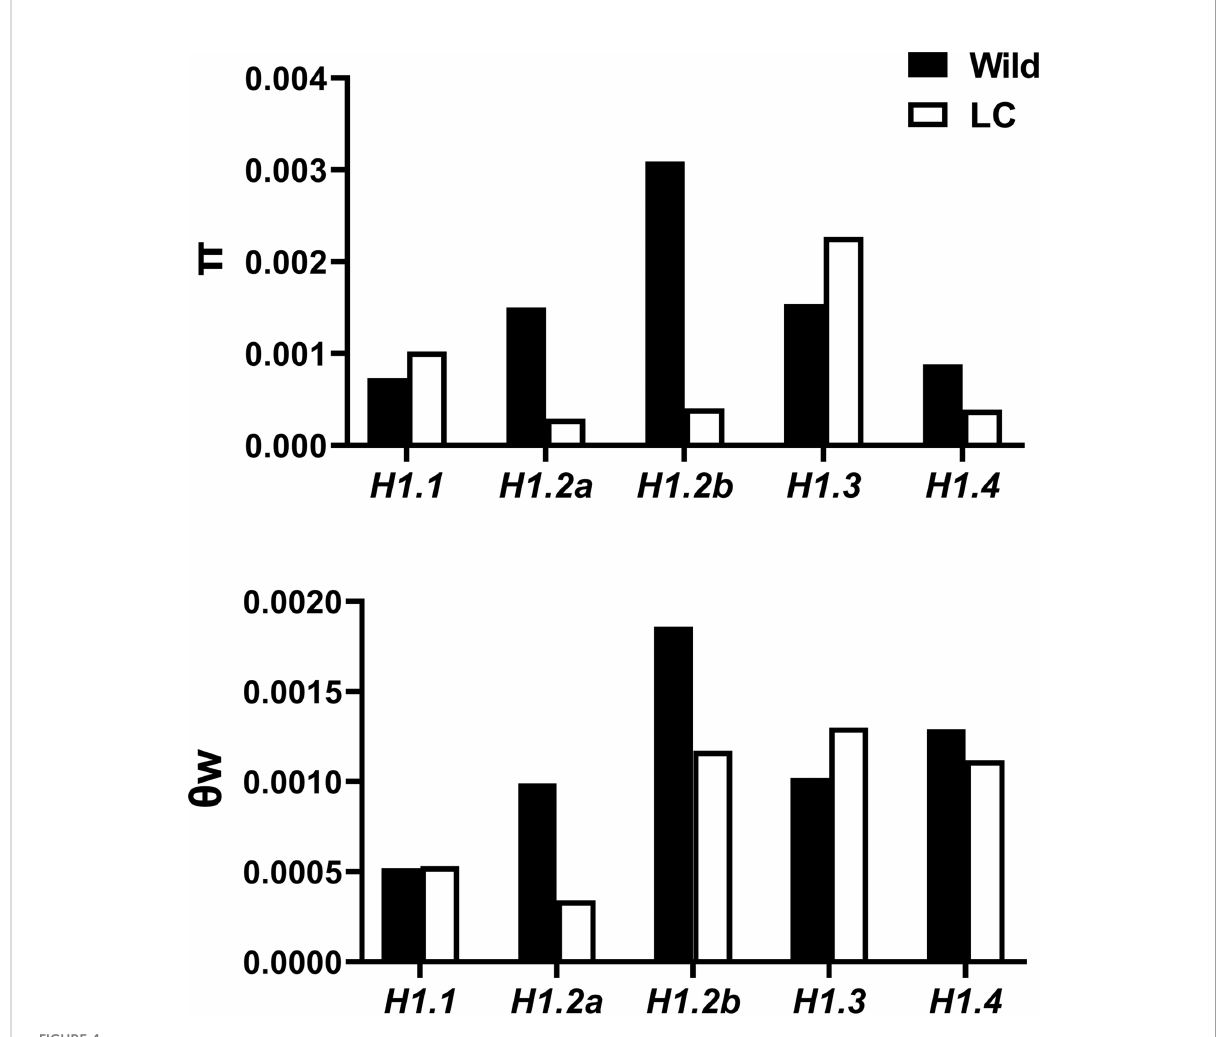
FIGURE 4 p and q w of H1 genes in wild and landrace/cultivated (LC)